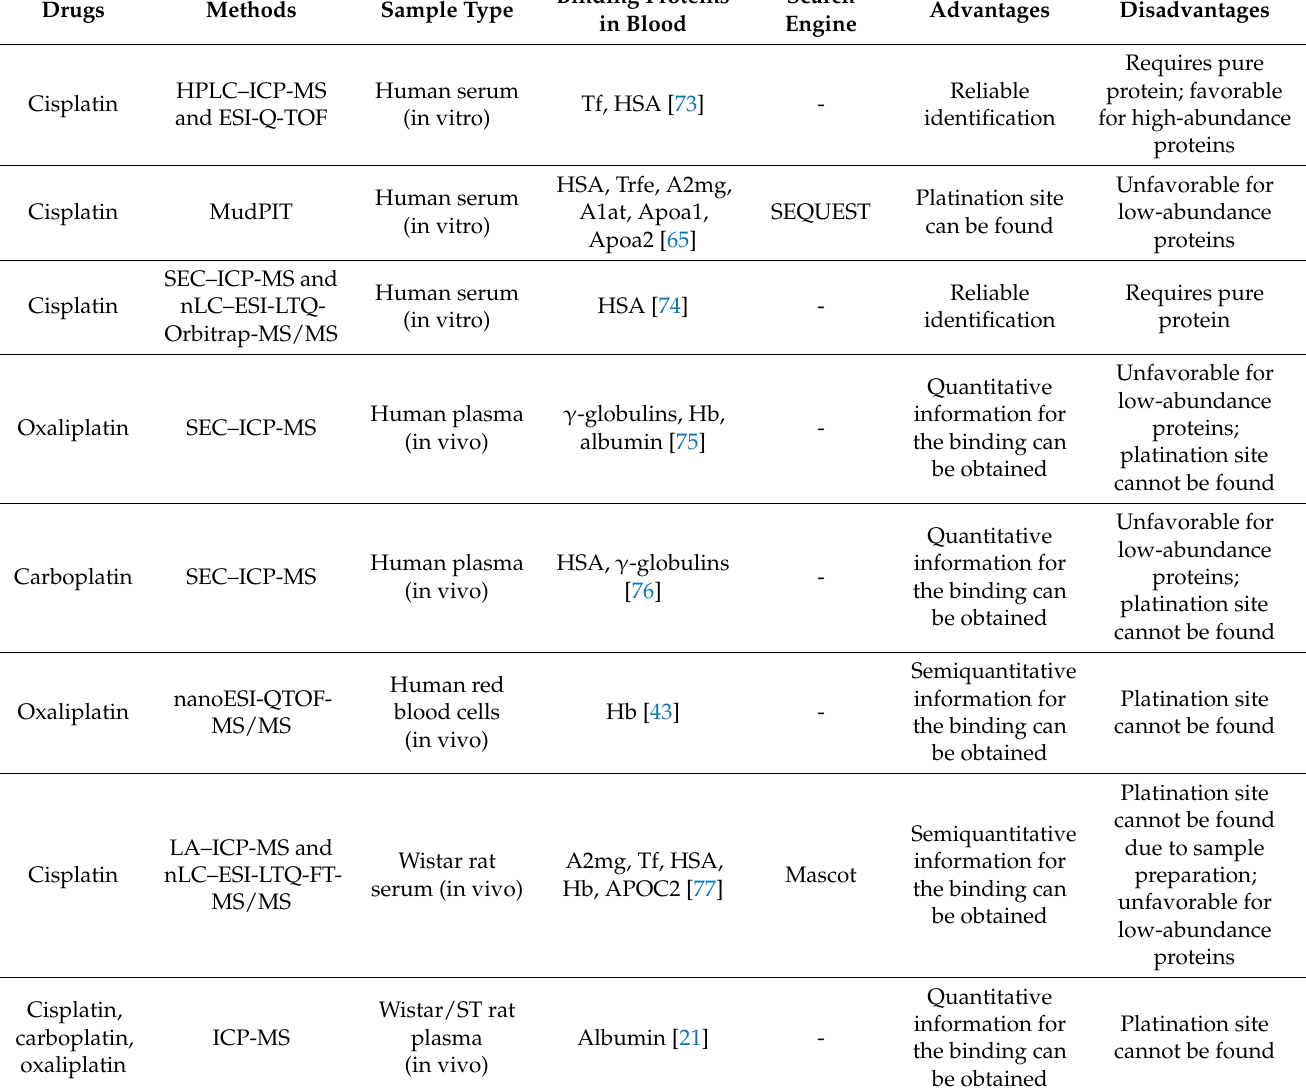
Table 2. Summary of the methods for studying the protein-binding behavior of platinum drugs in